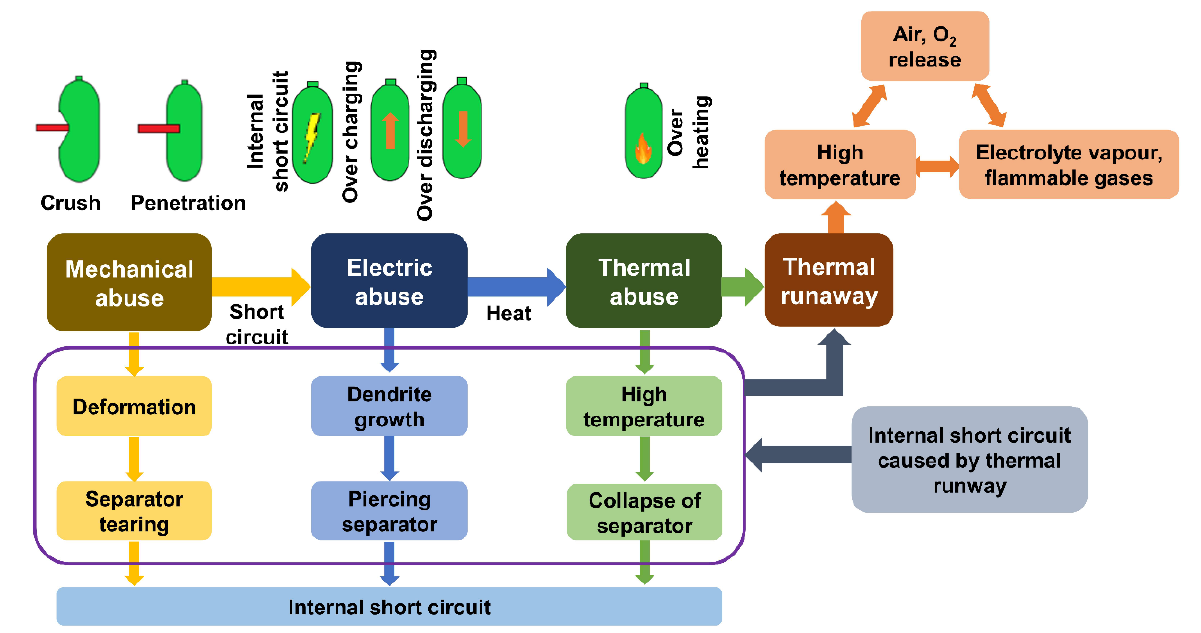
Figure 3. Scenarios that lead to Lithium-ion battery failure. Reproduced with permission from ref. [99]. Copyright 2019. Elsevier Ltd.